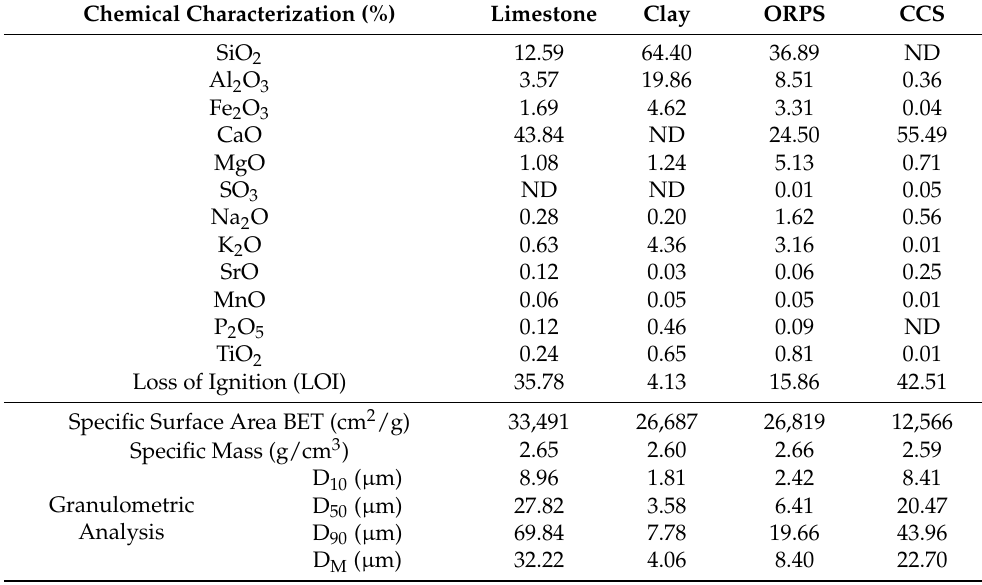
Table 3. Chemical composition and physical characterization of the raw